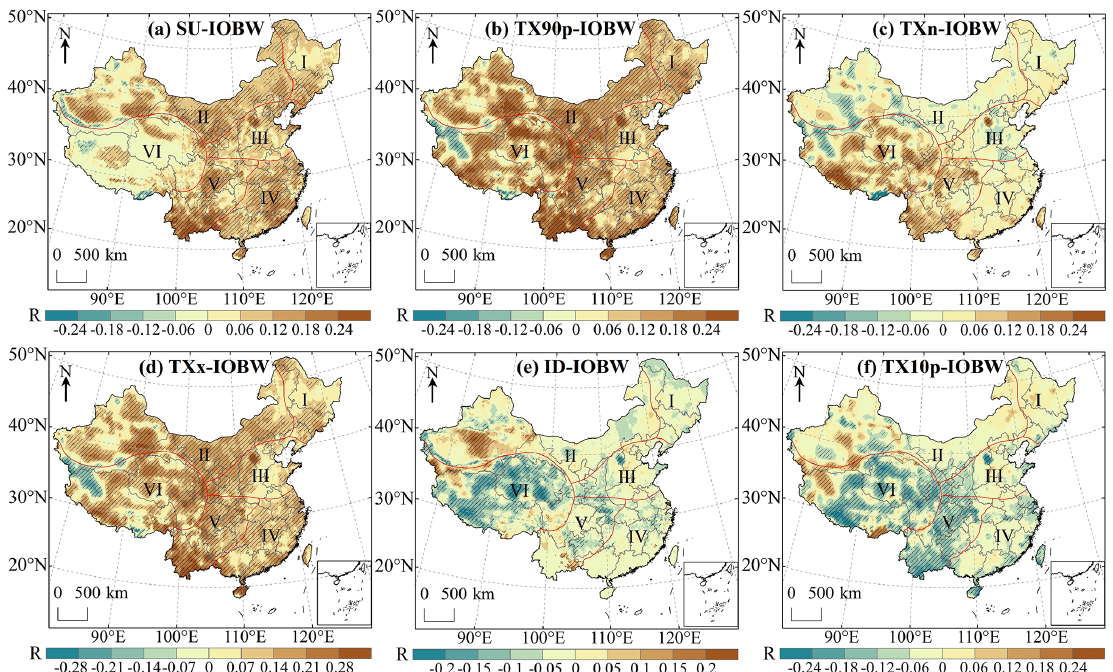
Figure 19. Correlation analysis between extreme temperature indices and IOBW in China during 1979–2018. The shaded areas indicate correlations that are significant at the 0.05